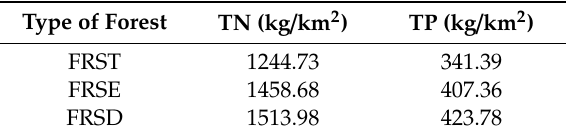
Table 5. Annual output intensity of TN and TP in different FLTs.